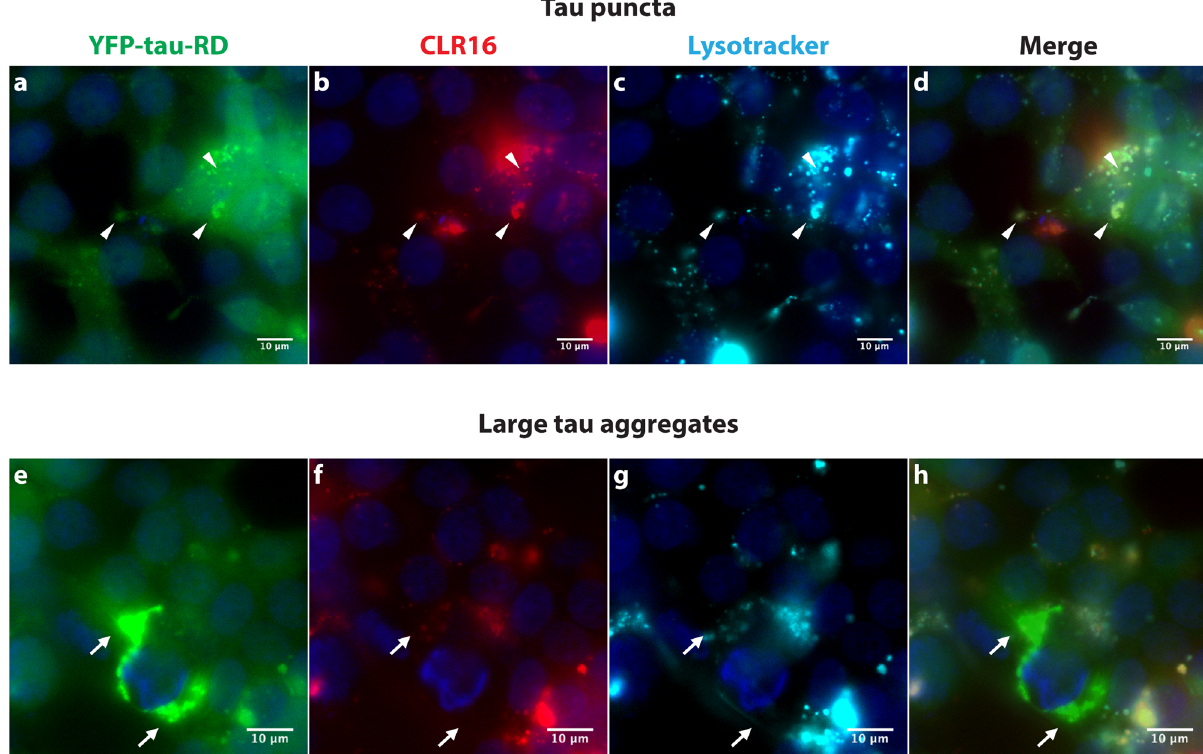
Fig. 8 CLR16 colocalizes with tau aggregates in lysosomes. Biosensor HEK293 cells were treated with a brain extract from a PS19 transgenic mouse to induce tau aggregation, Then, 5 µ M CLR16 and LysoTracker were added. a – d CLR16 colocalized with small tau puncta at lysosomes (white arrowheads). e – h CLR16 did not colocalize with large tau aggregates (white